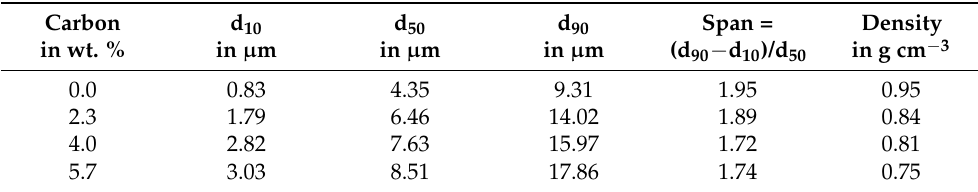
Table 2. Particle properties of CLM00007 based on non-classified CLM00001 showing increasing particle aggregation with rising carbon content.